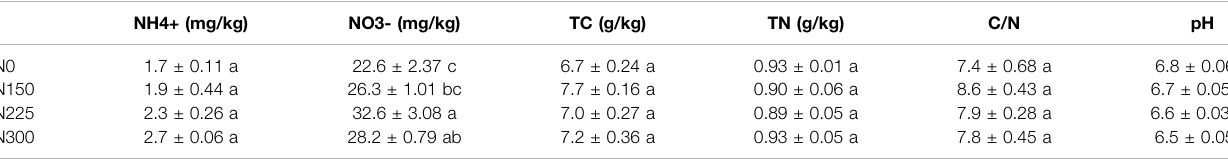
TABLE 1 | Soil properties (0 – 20 cm) of different nitrogen fertilization treatments in the lawn soils. NH4+ (mg/kg) NO3- (mg/kg)